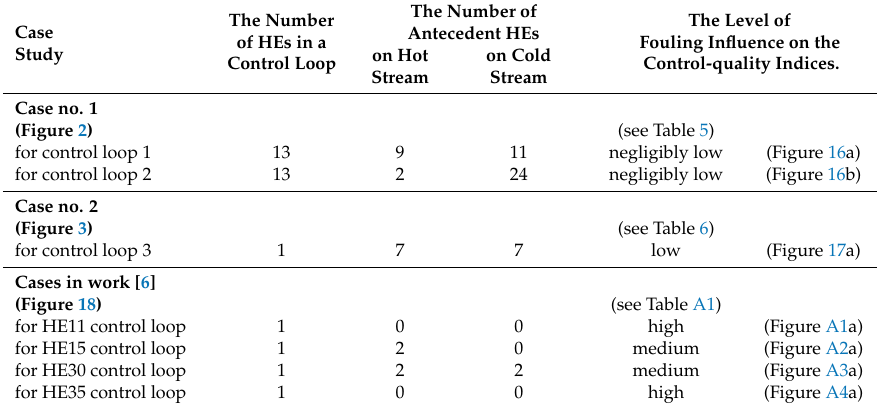
Table 7. The number of HEs in a control loop and the number of antecedent HEs compared to the level of fouling influence on the control-quality